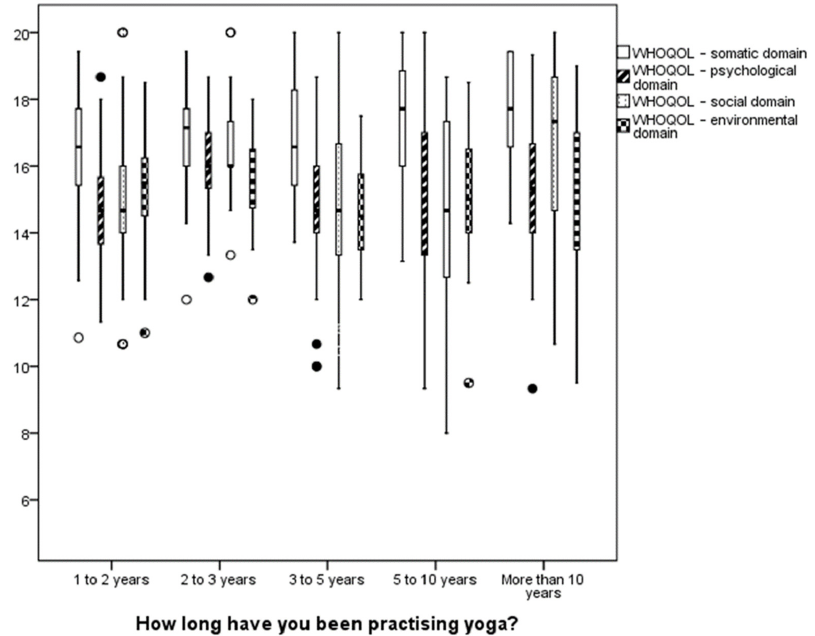
Figure 3. Graphic representation of quality-of-life domains of groups with varying yoga practice experience. Annotation. Lower boundary of the box—lower quartile; upper boundary of the box— upper quartile; line inside the box—median; o—observations from 1.5 to 3 quarter spacing from the box; •—outlier